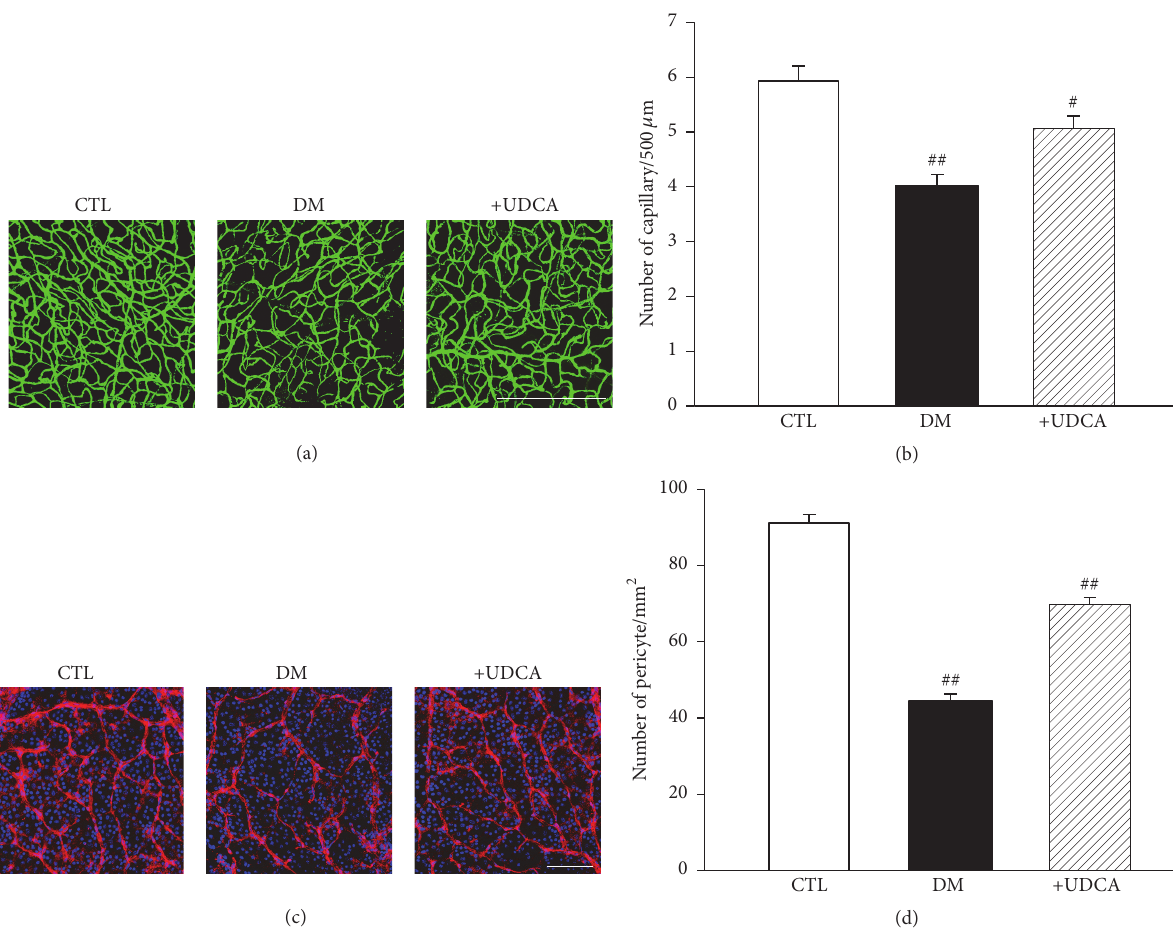
Figure 2: Effect of UDCA on pericyte loss in STZ-induced diabetic mice. (a) Representative images of FITC staining in control, nontreated diabetic, and UDCA-treated diabetic mice. Original magnification: × 200; scale bar: 500 𝜇 m. (b) Capillary density was lower in nontreated diabetic mice, while no differences were observed between UDCA-treated diabetic and control mice. Fifteen measures of capillary density were averaged for each retina from control ( 𝑛 = 5 ), nontreated diabetic mice ( 𝑛 = 5 ), and UDCA-treated diabetic mice ( 𝑛 = 5 ). ## 𝑃 < 0.001 versus control mice, # 𝑃 < 0.005 versus nontreated diabetic mice. (c) Representative images of PDGFR- 𝛽 staining for retinal pericytes in control, nontreated diabetic and UDCA-treated diabetic mice. Original magnification: × 200; scale bar: 200 𝜇 m. (d) The number of pericytes was lower in nontreated diabetic mice while no differences between UDCA-treated diabetic and control mice were evident. Measurements of pericyte number were averaged for each retina from control ( 𝑛 = 5 ), nontreated diabetic mice ( 𝑛 = 5 ), and UDCA-treated diabetic mice ( 𝑛 = 6 ). CTL: control mice, DM: nontreated diabetic mice, and +UDCA: diabetic mice treated with UDCA, ## 𝑃 < 0.001 versus control